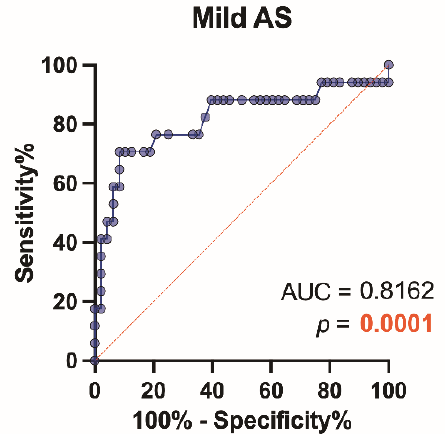
Figure 5. Receiver-operating characteristic curve for thioredoxin-1 (TRX1) as a diagnostic marker of AS (control group vs. mild AS patient group). AUC—the area under the curve.